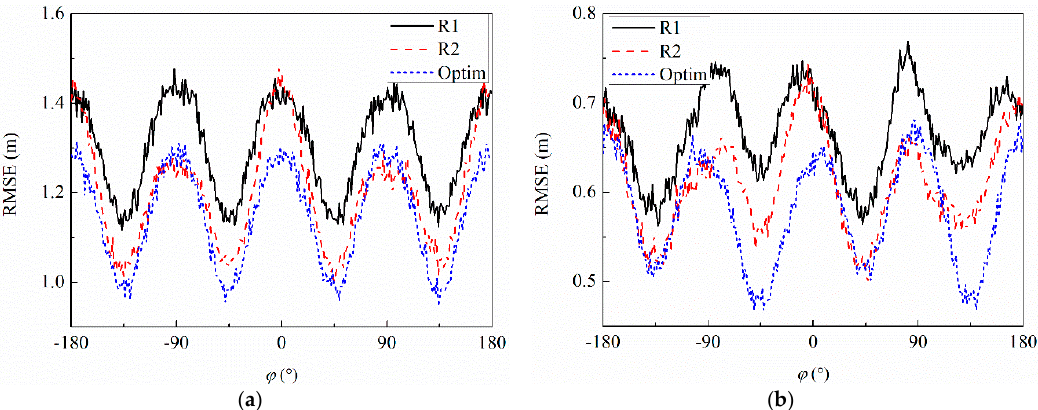
Figure 9. Comparison of root-mean-square errors (RMSEs) of optimized and reference arrays under different time-difference-of-arrival (TDOA) characteristics: ( a ) σ t was set as 0.4 ns; ( b ) t 31 and t 61 were contaminated by bias error of 0.2 ns.